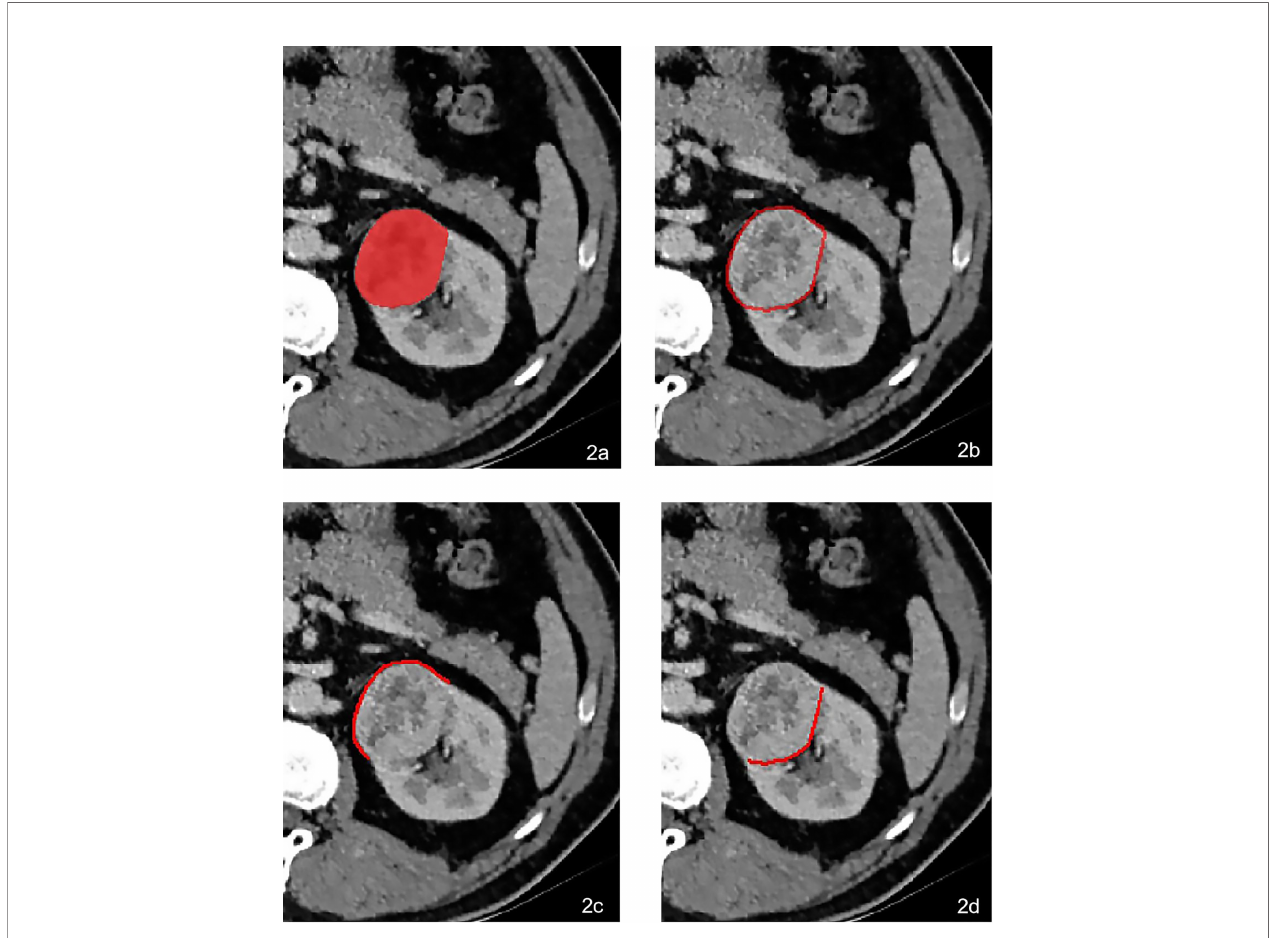
FIGURE 2 | A 64-year-old male was pathologically con fi rmed to be high-grade ccRCC in the left kidney. The VOI was delineated manually in (A) . The peritumoral VOI was then received after expending 2 mm automatically in AK software (B) . The peritumoral VOI was subdivided into peritumor-fat (C) and peritumor-kid (D) according to the different neighboring